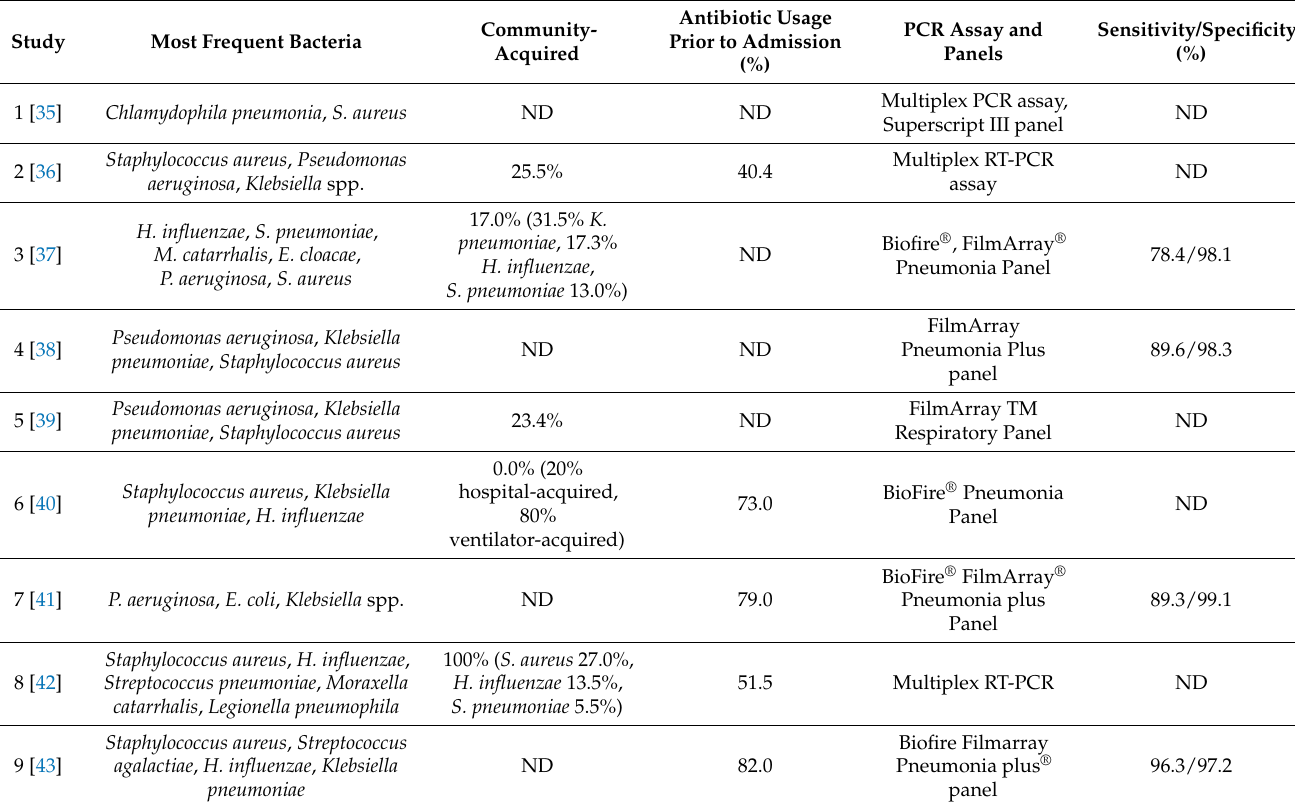
Table 3. Bacterial pathogens